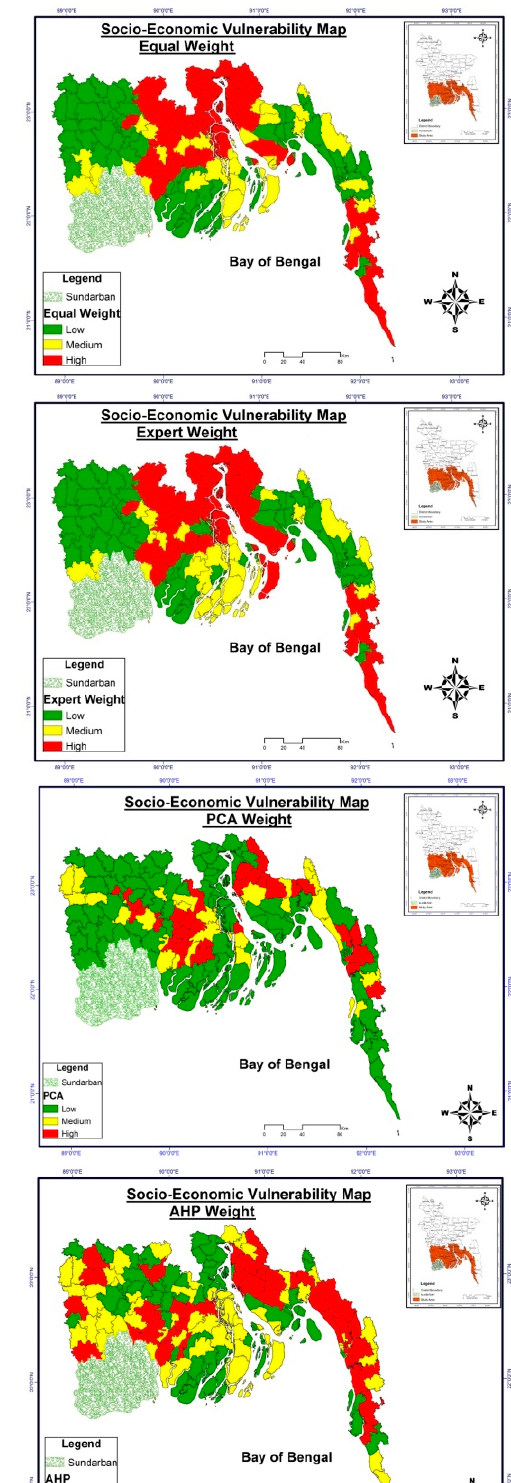
11 of 16 Figure 3. Comparison between storm surge hazard map (left) and socio ‐ economic vulnerability map